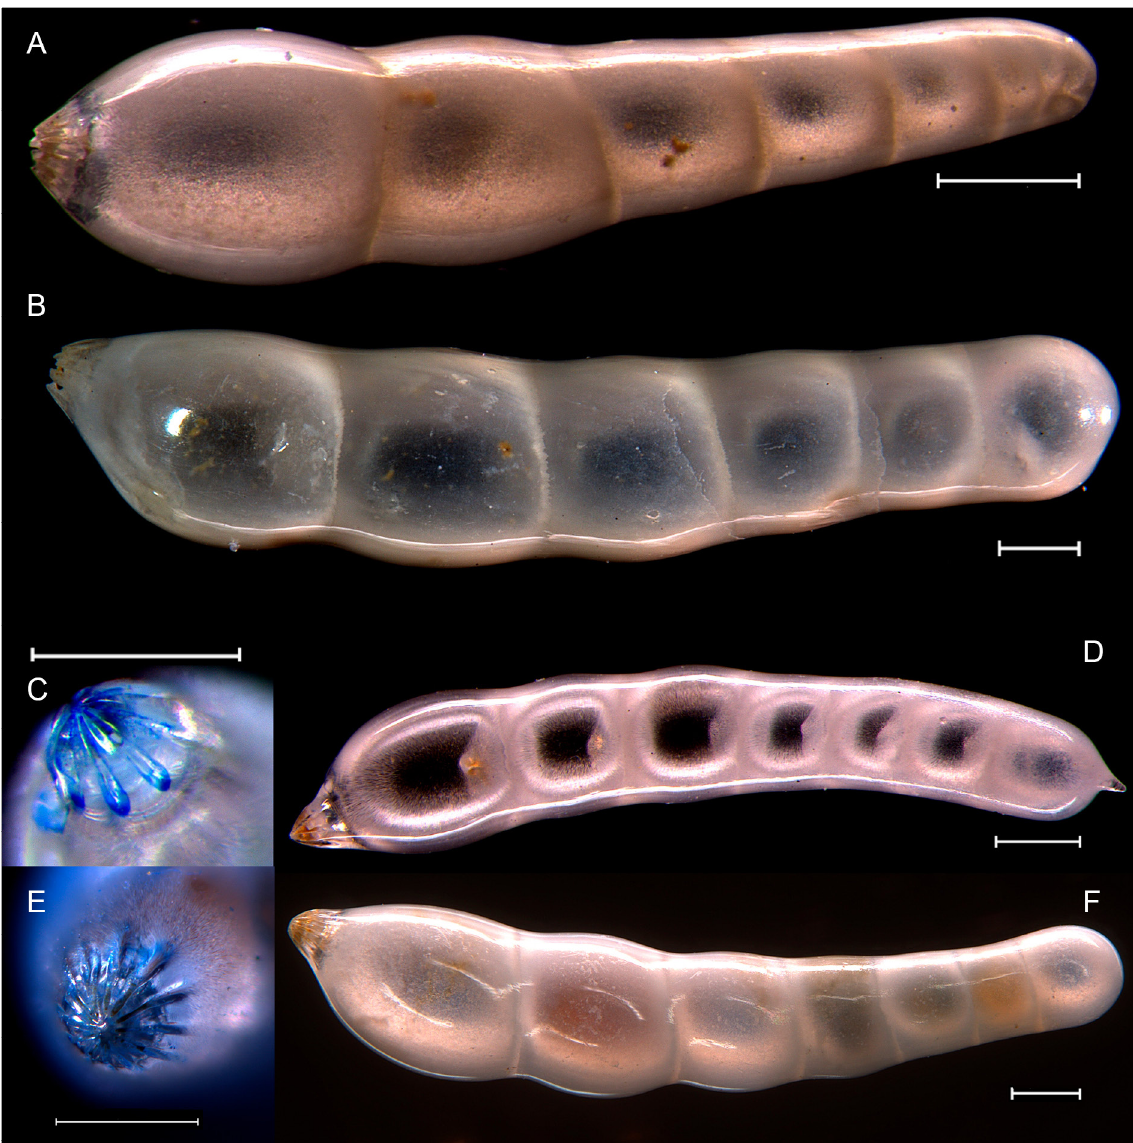
Fig. 3. Dentalina elegans d’Orbigny, 1846. A . Microsphere (BIOICE 2542, IINH 39684) with a spiral chamber arrangement at initial end; light source a combination of Rotterman contrast and dark field, resulting in a coarse appearance. B . Megalosphere (Biocie 2362, IINH 39758), side view showing surface edges of the secondary surface laminations. C–D . Megalosphere (BIOICE 3627, IINH 39842) aperture (C) stained with indigo blue and same specimen with a short spine at initial end (D). E–F . Megalosphere (BIOICE 2049, IINH 39697), aperture (E) stained with indigo blue and side view (F). Light source in B–F is a combination of incident light and dark field. Scale bars = 0.25